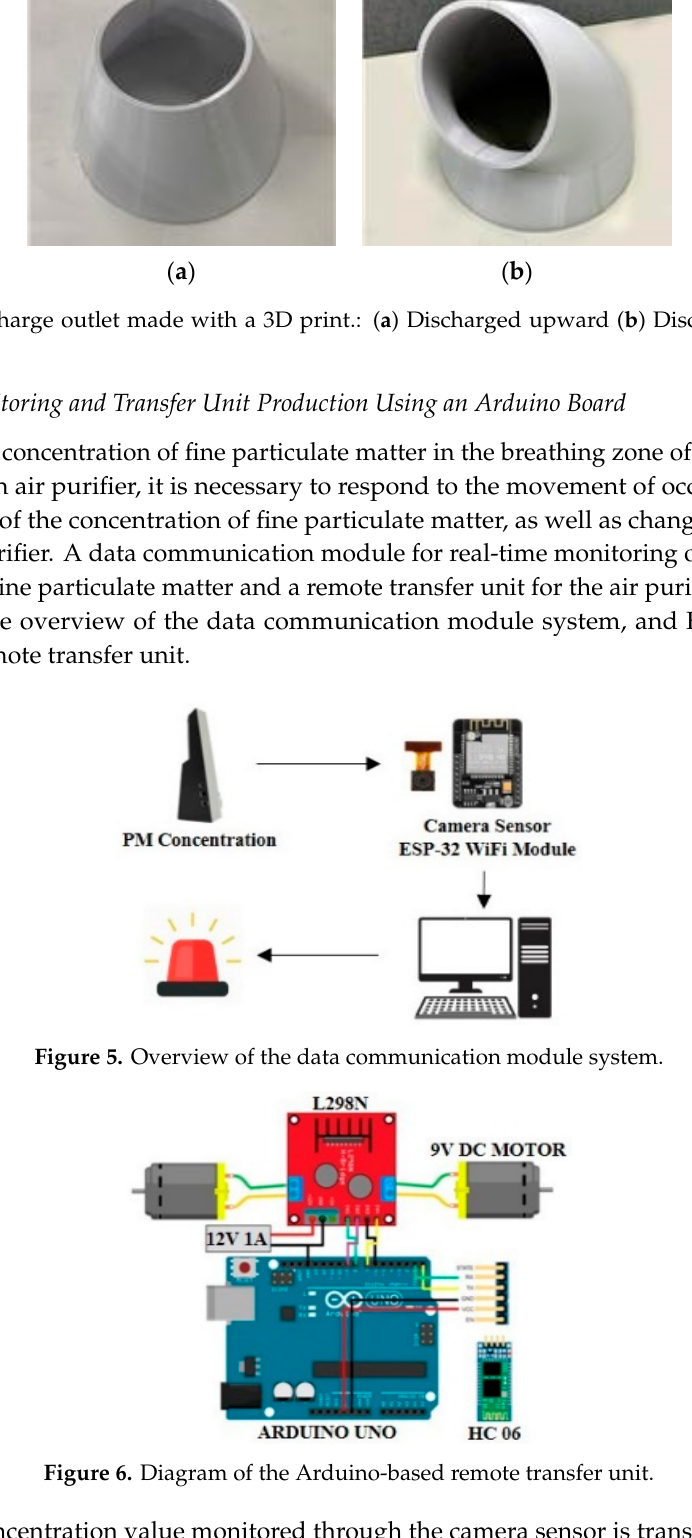
Figure 4. Discharge outlet made with a 3D print.: ( a ) Discharged upward ( b ) Discharged toward occupants.